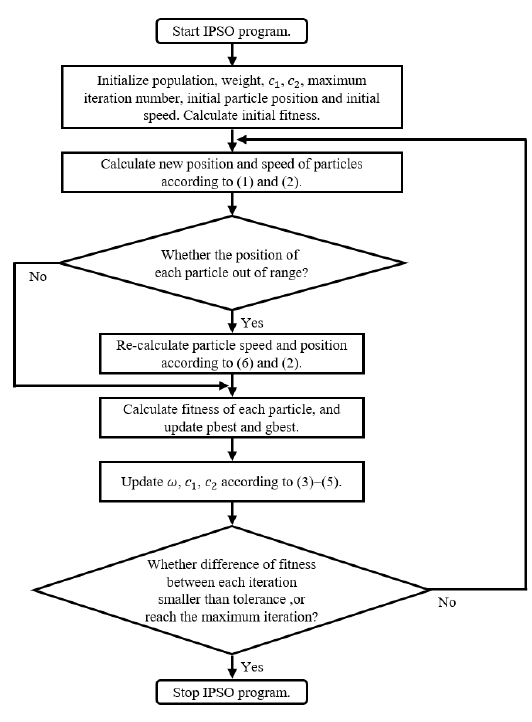
Figure 12. The IPSO flowchart .